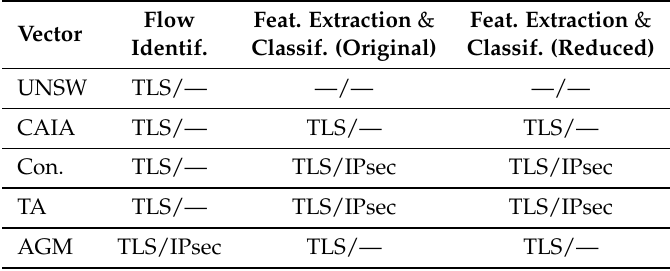
Table 7. Compatibility between feature vectors and encryption methods (TLS and